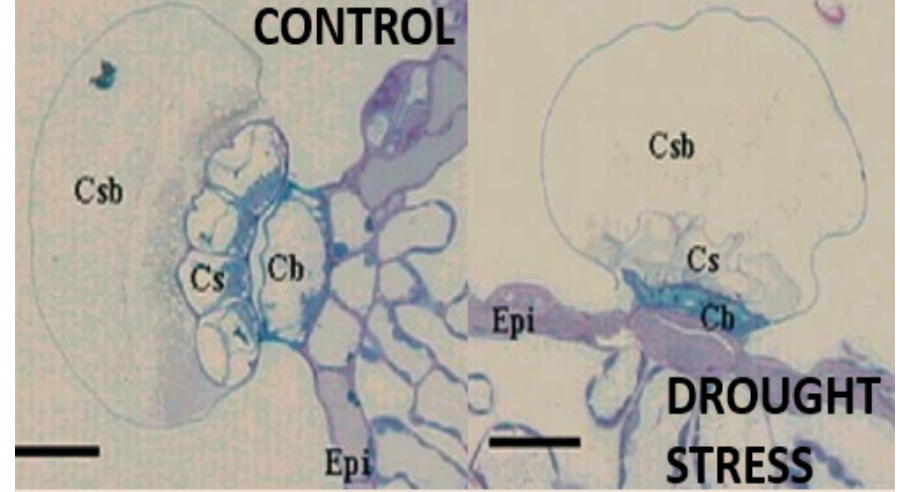
Figure 3. Changes in the peltate glandular trichomes of rosemary. Cb, basal epidermal cell; Csb and Cs, secretory cells; CsB, great cavity or secretory head; Epi, epidermis. Bars: 25 µm. The cuticle is not seen in Csb. Image courtesy of [34].